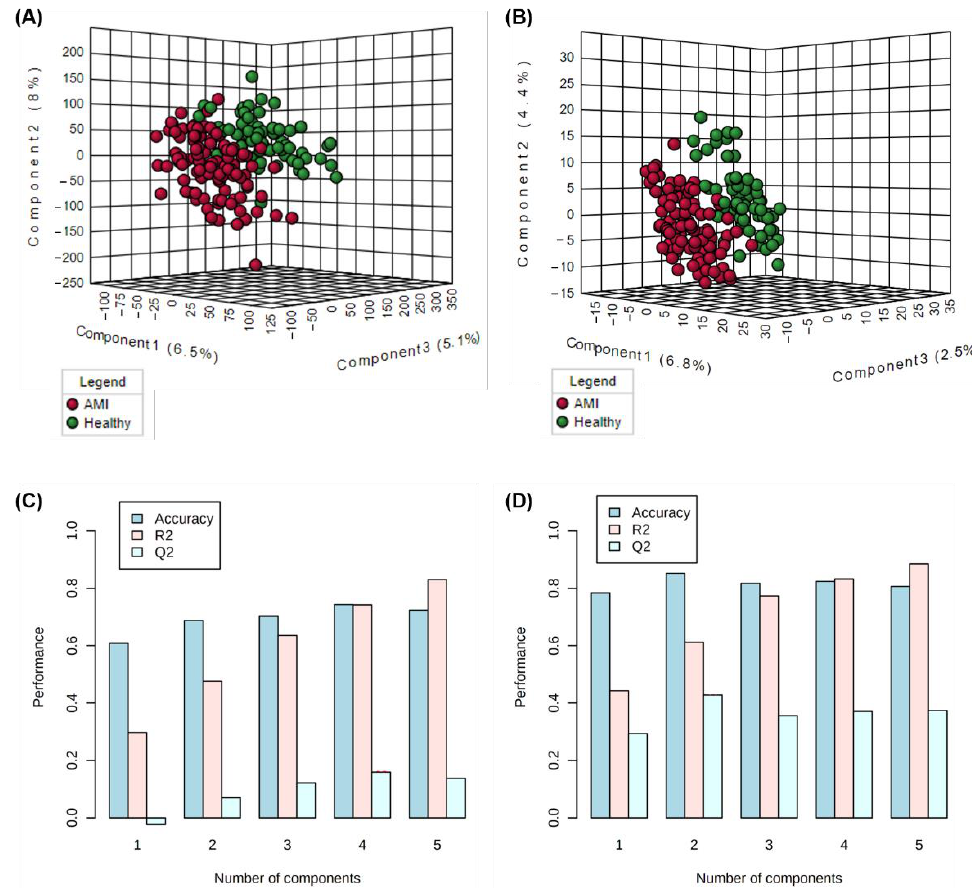
Figure 1. PLS-DA score plots for the visualisation of clustering of AMI versus healthy samples based on ( A ) lipidomics and ( B ) metabolomics analysis, and the corresponding model performance measures across the number of components generated from ( C ) metabolomics and ( D ) lipidomics analysis.